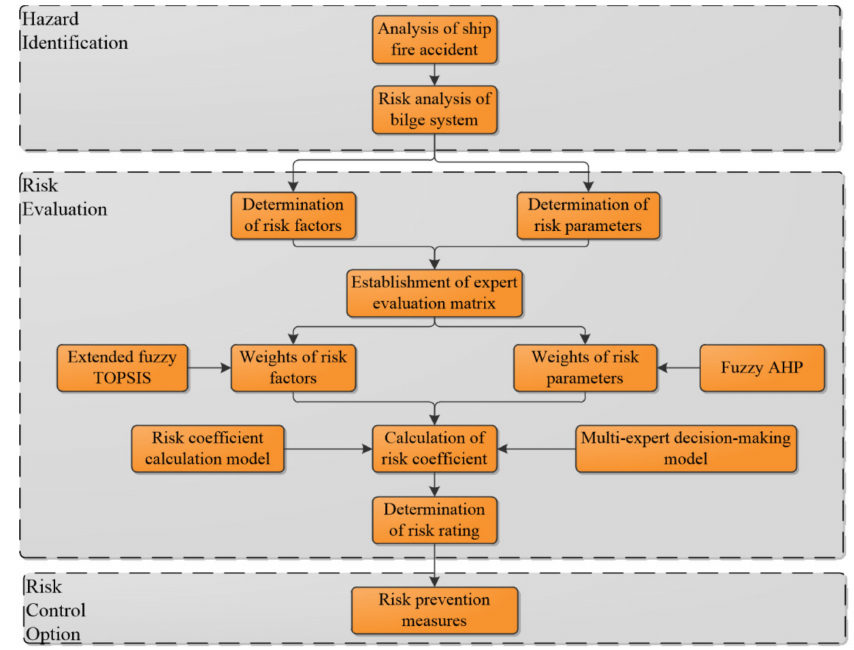
Figure 1. Failure risk assessment for a large luxury cruise ship’s bilge